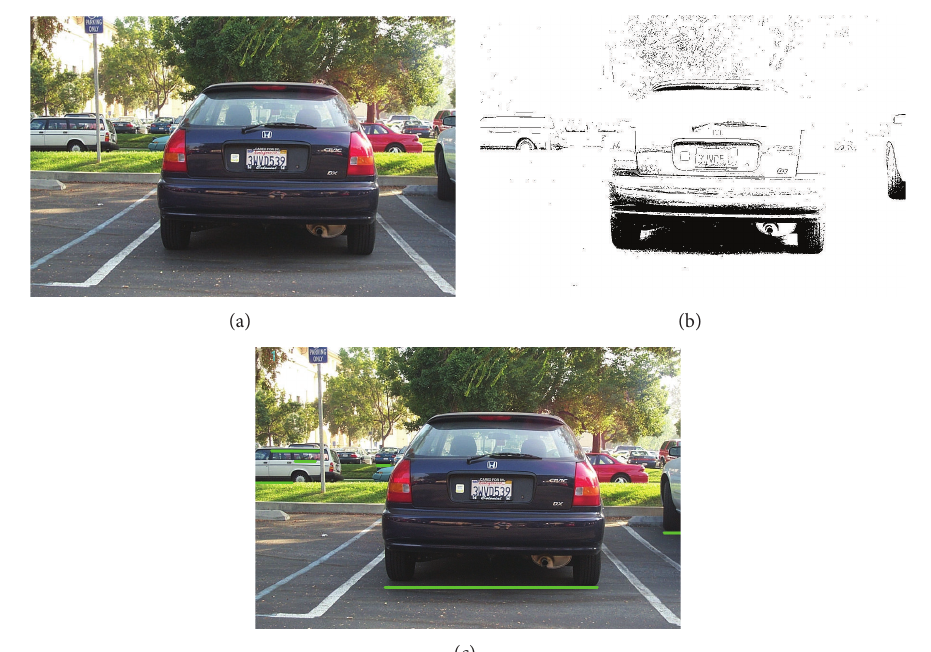
Figure 2: Result of shadow-based vehicle ROI detection method.